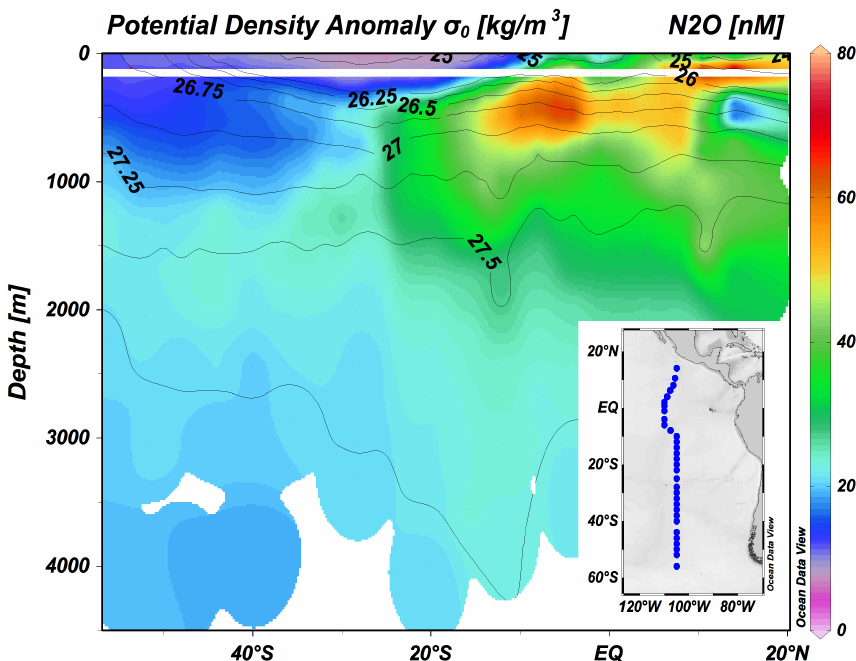
Fig. 3. Section of N 2 O (nM) concentrations from the RITS89 cruise. In the tropical and subtropical Eastern Pacific, the bulk of N 2 O is located in the upper 800m. The white line indicates 150m depth (above which data were excluded for reasons discussed in the